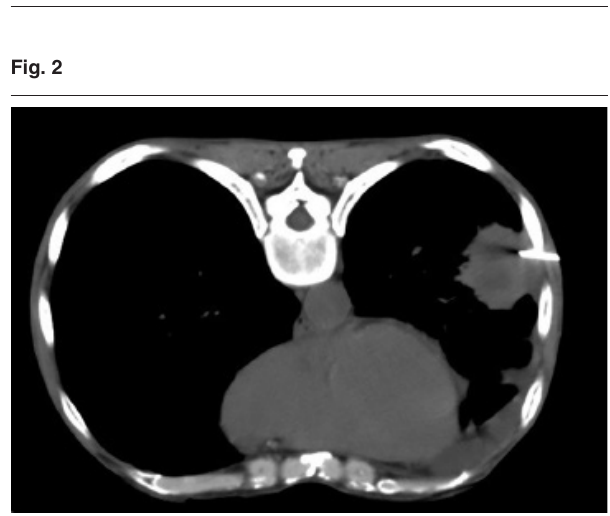
Computed tomographic scan of the thorax shows a well-defined heterogeneously attenuated mass lesion in the anterior segment of the left lower lobe of the lung with core biopsy needle in situ .